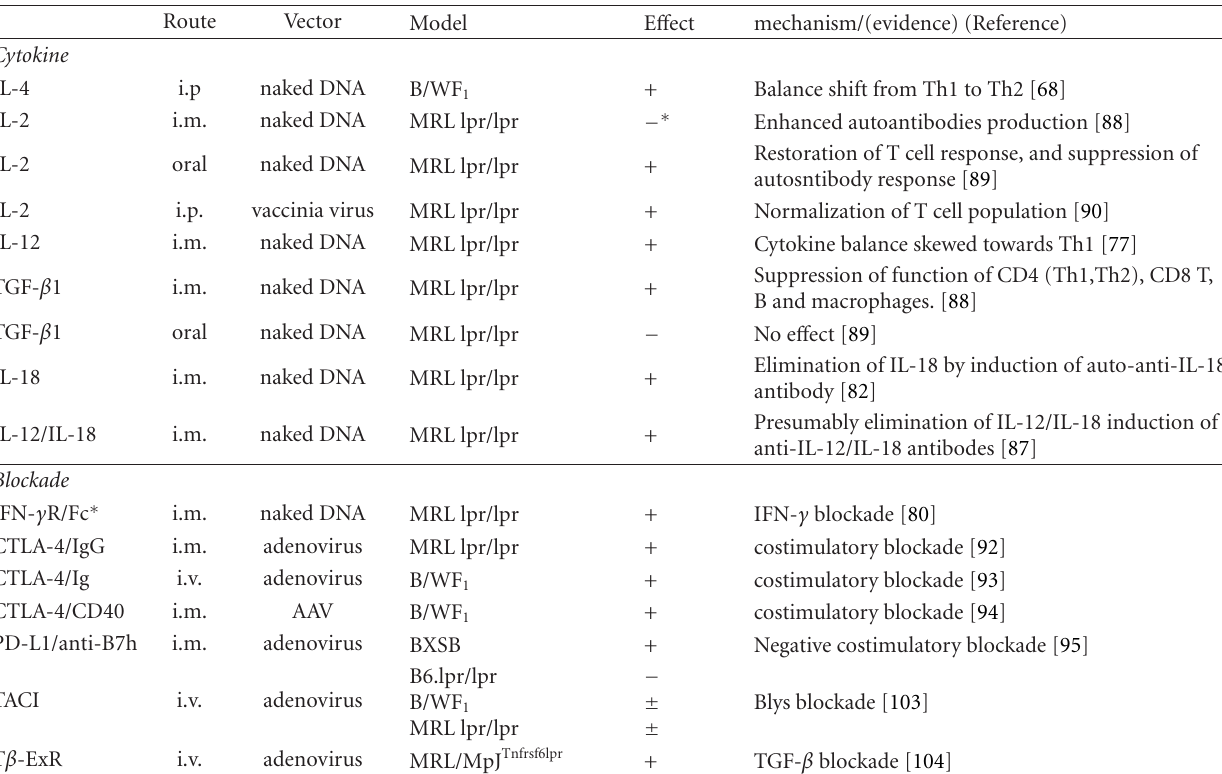
Table 1: Several gene therapies in lupus model